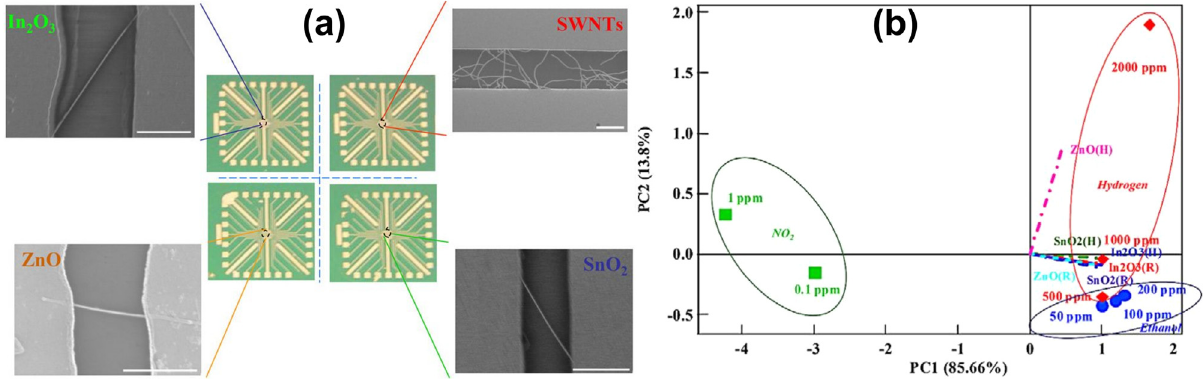
Figure 4: ( a ) Sensor array chip composed of four individual chemical sensors, including individual In 2 O 3 nanowire, SnO 2 nanowire, ZnO nanowire, and SWNT chemical sensor chips. ( b ) PCA scores and loading plots of the chemical sensor array composed of only the three metal oxide single nanowires. Edited with permission from ref. [ 20 ]